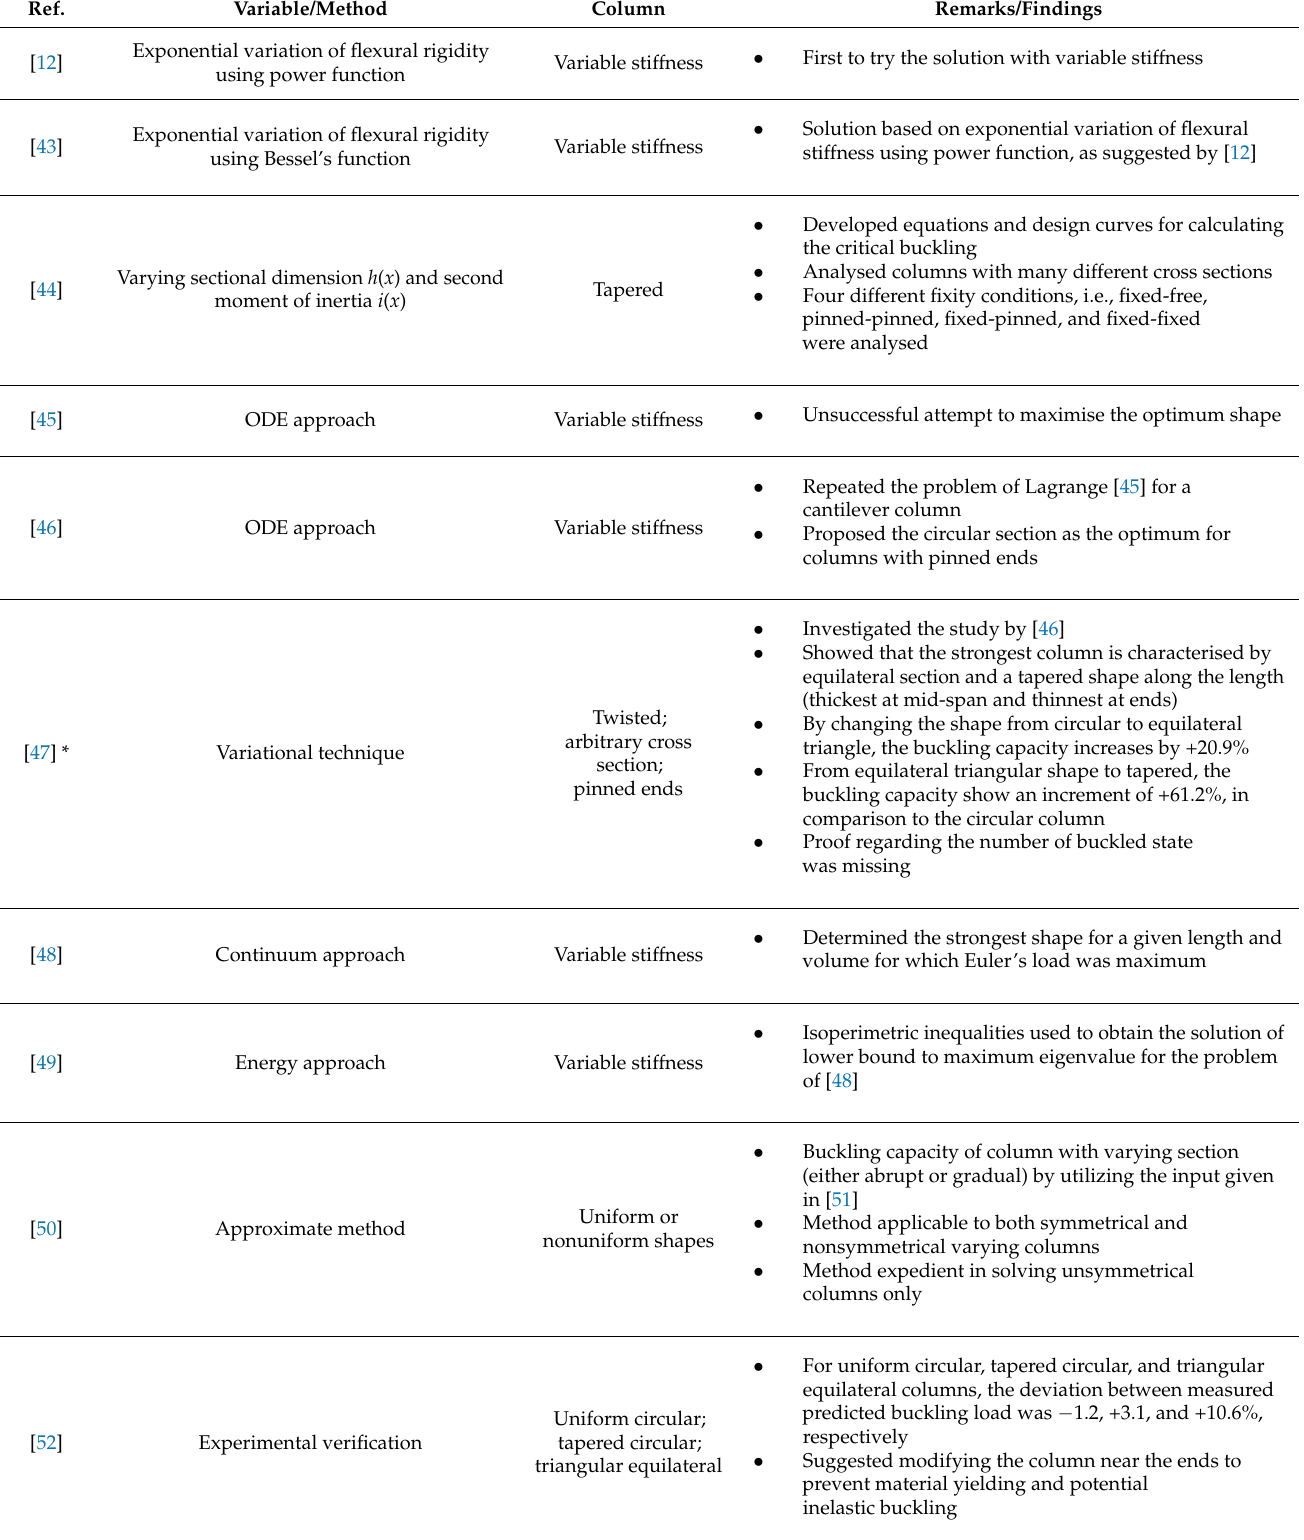
Table 1. Summary of research on nonprismatic columns using continuum or numerical approaches.